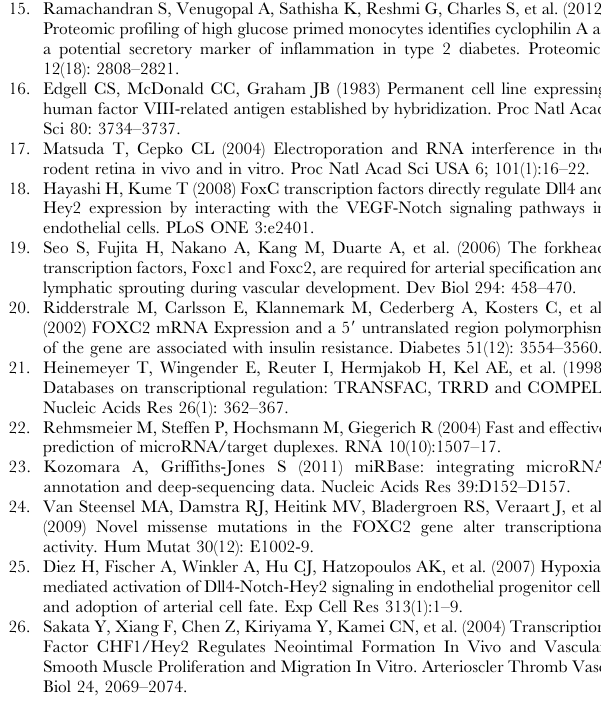
Table S1 Primers used for PCR and sequencing of 5 9 flanking region, 3 9 flanking regions and coding sequence of FoxC2 gene. Table S2 Primers used for quantitative real time PCR and luciferase reporter assay. Table S3 Patients and controls categorized as first group with neither or any single polymorphism and second group with 2, 3 or more